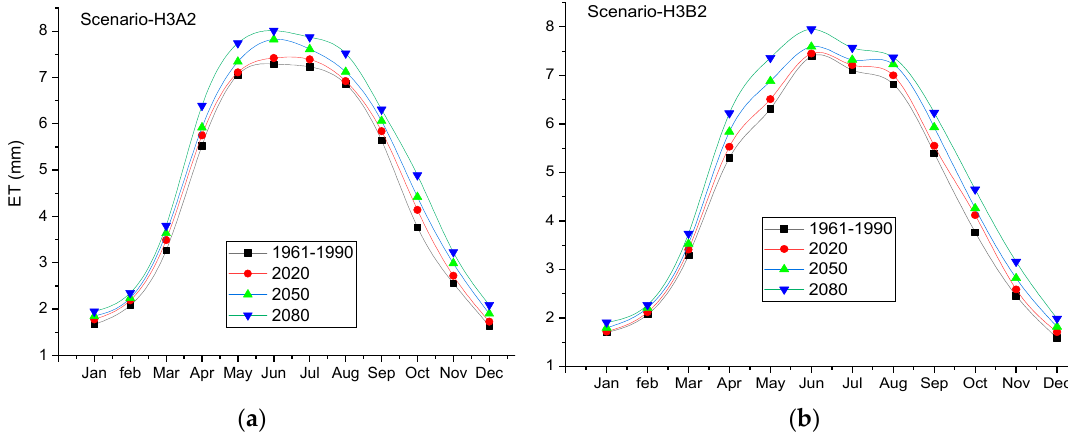
Figure 6. Predicted changes in mean monthly evapotranspiration (mm day − 1 ) in the baseline (1961–1990) and the future (2020s, 2050s, and 2080s) under ( a ) H3A2 and ( b ) H3B2 scenarios.